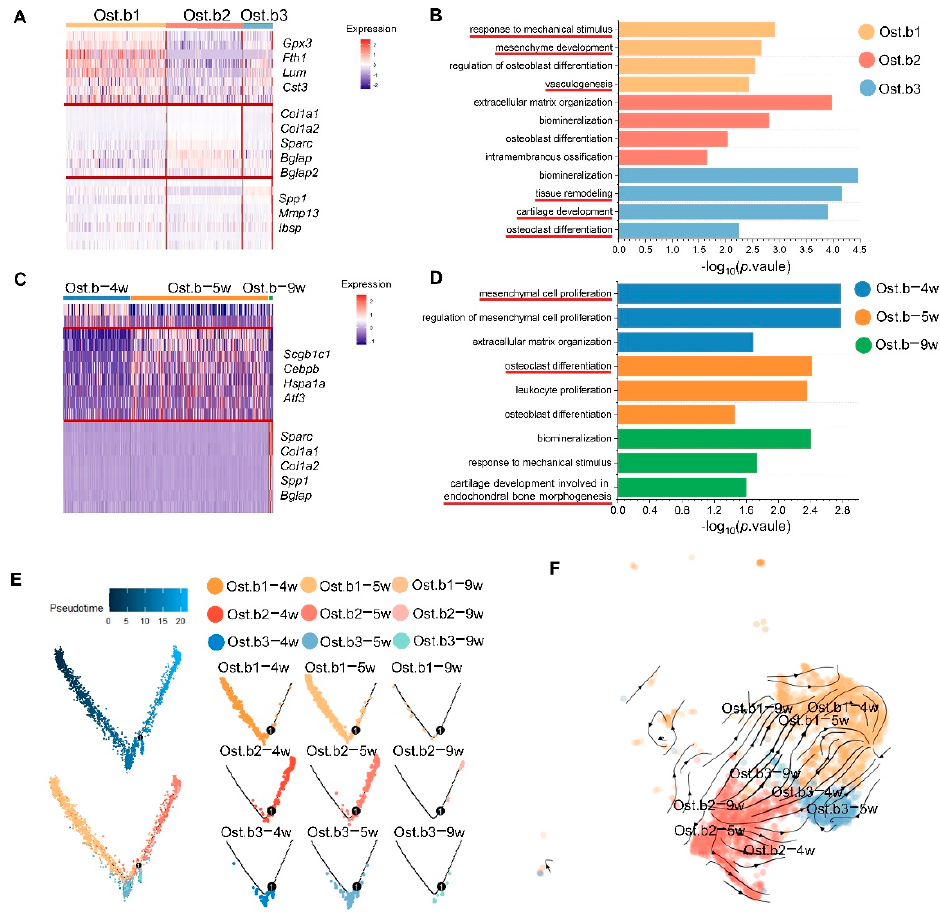
Figure 3. Different clusters of osteoblastic mesenchymal cells have different roles in the intramem- brane osteogenesis of the midpalatal suture (mouse model). ( A , C ) Heatmaps showing the average expression of the top differentially expressed genes for each cluster of osteoblastic mesenchymal cells divided by unsupervised clustering (( A ), Ost.b1, Ost.b2, and Ost.b3) and over time (( C ), Ost.b − 4w, Ost.b − 5w, and Ost.b − 9w). ( B , D ) Bar graphs showing the enriched gene ontology terms between Ost.b1, Ost.b2, and Ost.b3 ( B ) and between Ost.b − 4w, Ost.b − 5w, and Ost.b − 9w ( D ). ( E ) Pseudo- time trajectory analysis of nine subclusters of osteoblastic mesenchymal cells colored by cell cluster. ( F ) RNA velocity of each cluster of osteoblastic mesenchymal cells colored by cell